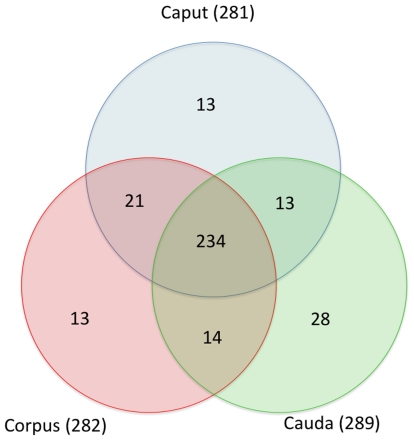
Venn diagram comparing miRNA expression in three human epididymal regions (caput, corpus and cauda).A threshold has been applied to detect miRNAs expressed with a Log 2 intensity >3.2 in at least one epididymal region.